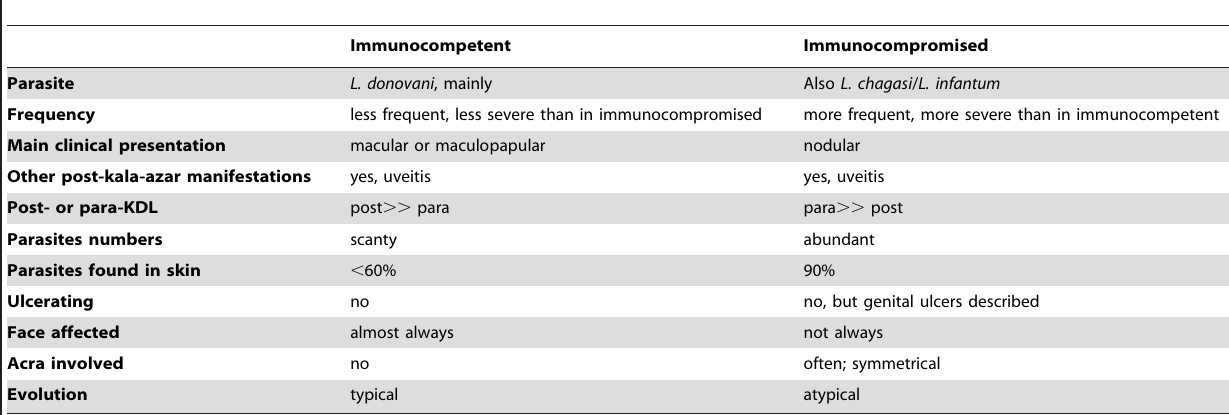
Table 2. Comparison of PKDL and PKDL-like lesions in immunocompetent and in immunocompromised patients.